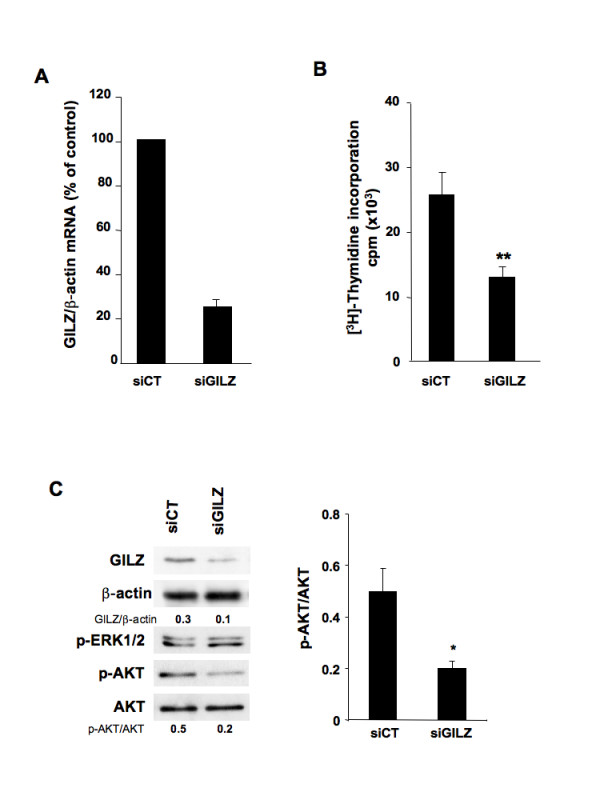
GILZ down-regulation reduces cell proliferation and AKT phosphorylation in BG-1 cells. BG-1 cells were transfected with 4 μg of control (siCT) or GILZ-specific (siGILZ) siRNA. (A) GILZ mRNA assayed by real-time RT-PCR and normalized to β-actin mRNA, 48 h after transfection. Results expressed as percentage of control from three independent experiments, mean ± SE. (B) Cell proliferation assayed by [3H]-thymidine incorporation 48 h after transfection with siRNA, mean ± SD, unpaired Student's t test was used for comparisons, **P < 0.01. (C) Left: total protein lysates were analyzed by western blotting using specific Abs. Blots: one representative experiment of three. Right: p-AKT expression levels were quantified by densitometric analysis and normalized to the signal for total AKT. Histogram represents mean ± SE of three experiments. Unpaired Student's t test was used for comparisons, *P < 0.05.